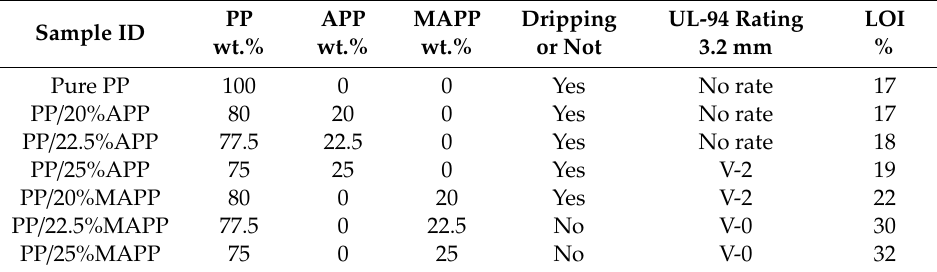
Table 1. Detailed results for PP and its flame-retardant blends from UL-94 and LOI